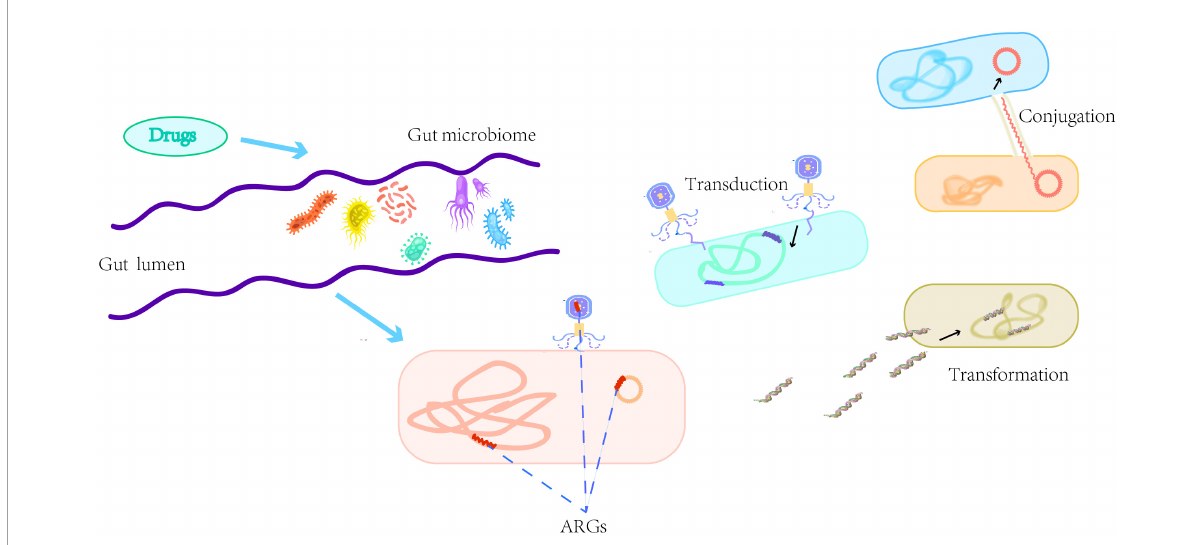
FIGURE1 A brief description of the emergence of antibiotic resistance genes (ARGs) and the main horizontal gene transfer modes of ARGs in the gut including transformation, transduction, and conjugation. Transformation refers to the taking up of naked deoxyribonucleic acid from the environment by physiologically competent bacteria. Transduction refers to the transfer of phages carrying genetic material between donor and recipient bacteria. Conjugation refers to mobile genetic elements, such as plasmids, transferring through a pilus formed between the donor and recipient